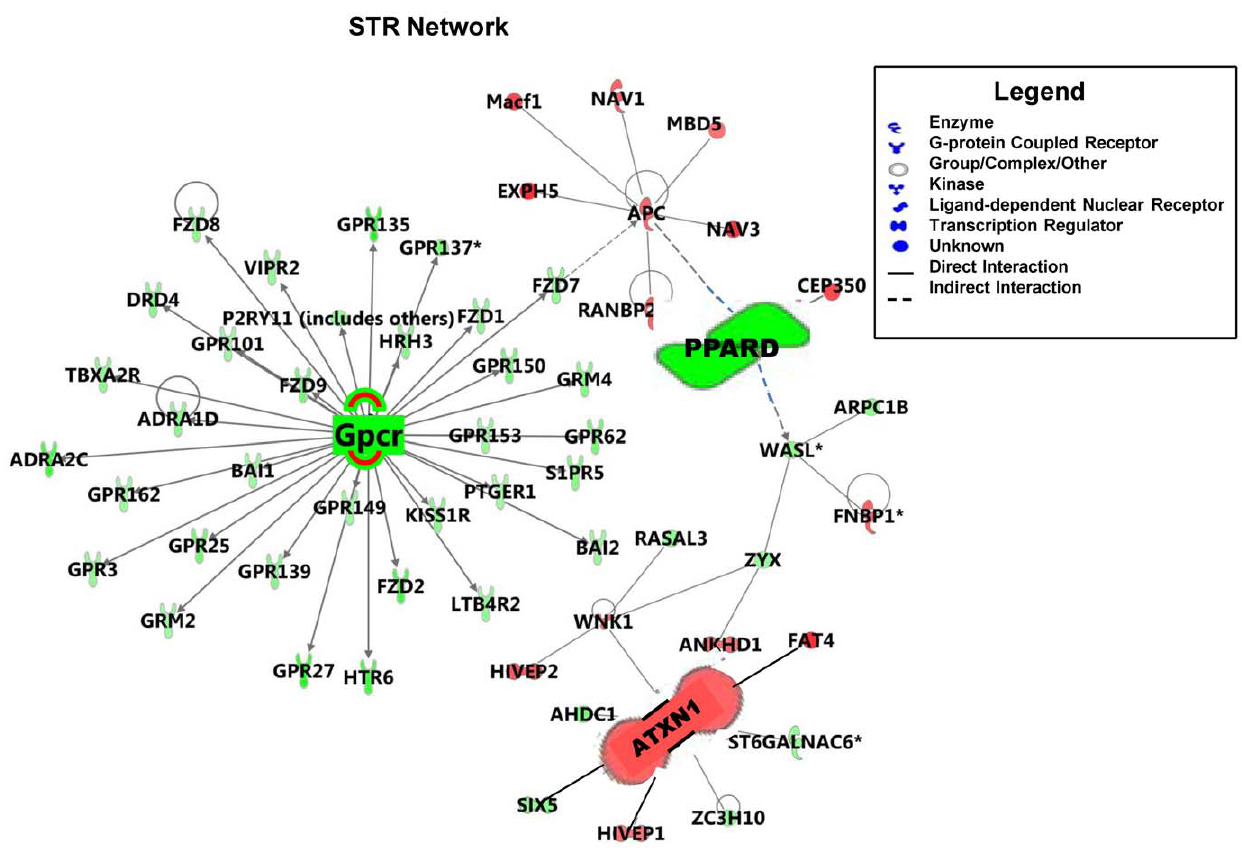
Figure 7. Global gene network in STR of PQ, PY and MNPQ mouse models of PD. The genes from the most significant network of each individual pesticide mouse model were overlayed to generate global gene networks in the STR. Down-regulated genes are highlighted in green, up- regulated genes are highlighted in red. The focus molecules- G protein coupled receptors (GPCRs) members and Ppar d are down-regulated while Atxn1 is up-regulated.